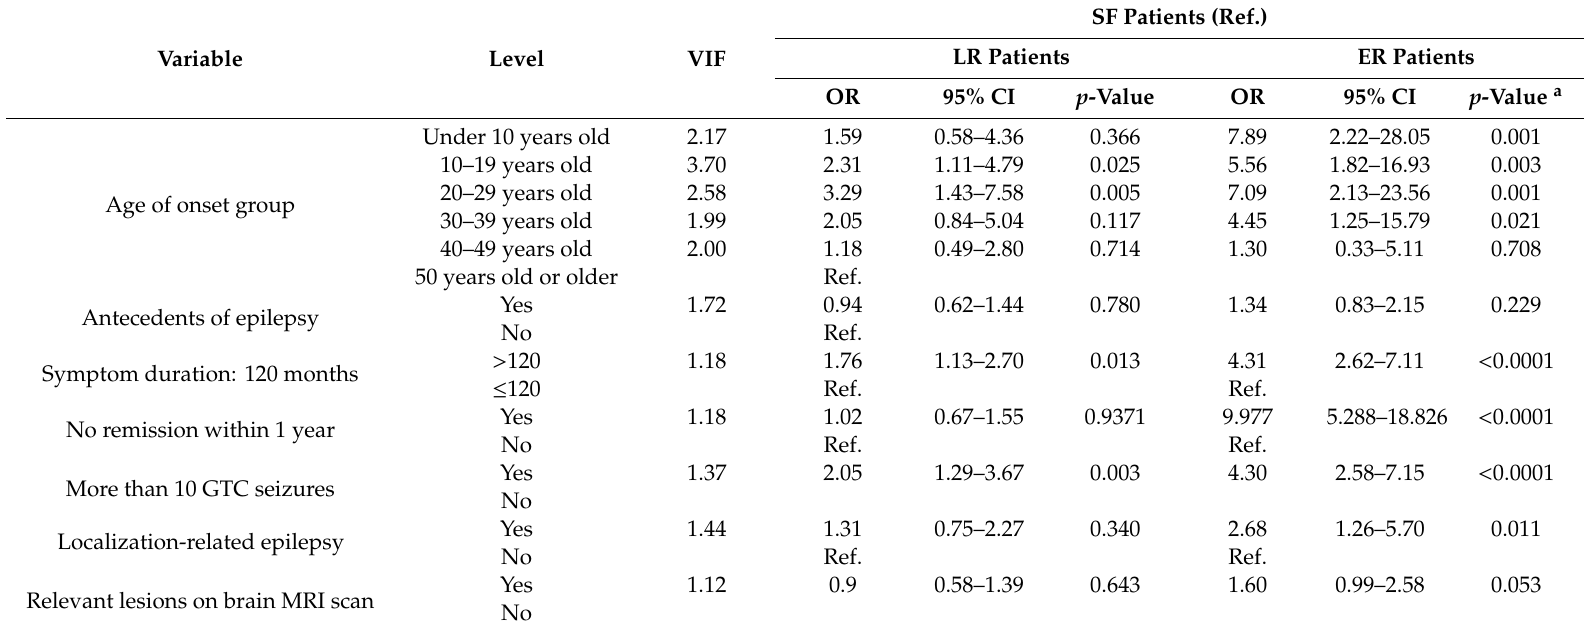
Table 3. Prognostic analysis with a univariable multinomial model in relapsed patients with SF patients as the